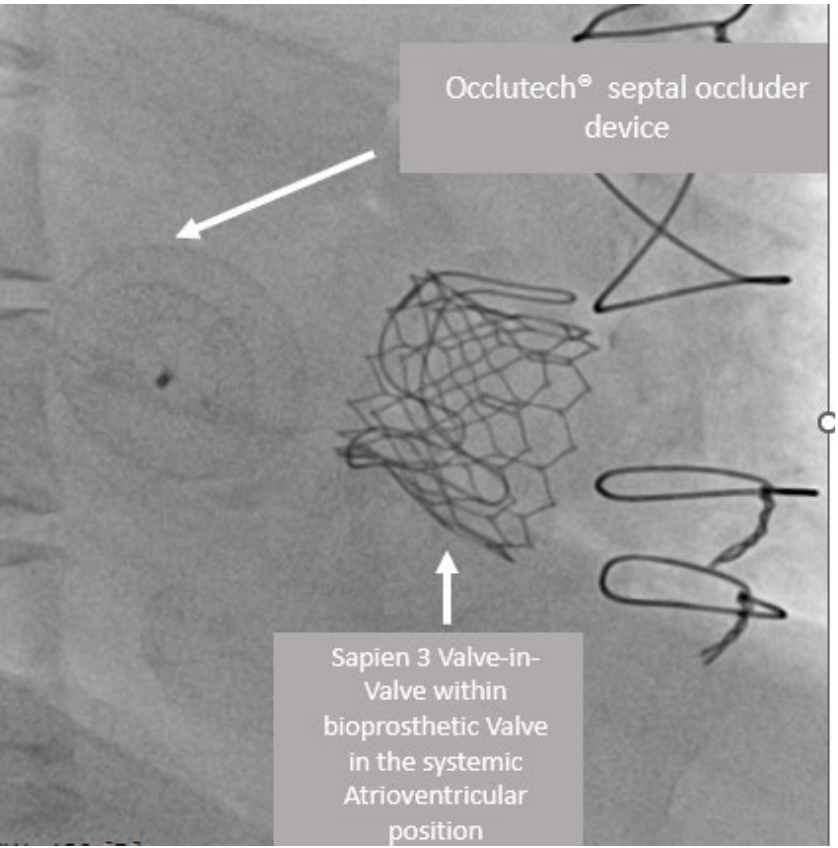
Figure 1. Sapien 3 valve-in-valve within bioprosthetic Valve in the systemic atrioventricular position with Occlutech ® septal occluder device as shown in the RAO